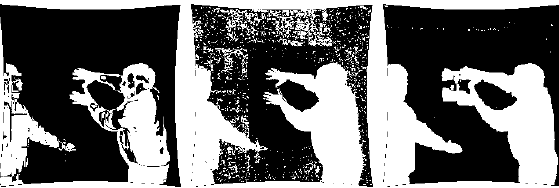
Figure 12: Thresholded difference images for intensity, range and thermal information (from left to right). Changes are indicated in white. Note the noisy behavior of range measurements.